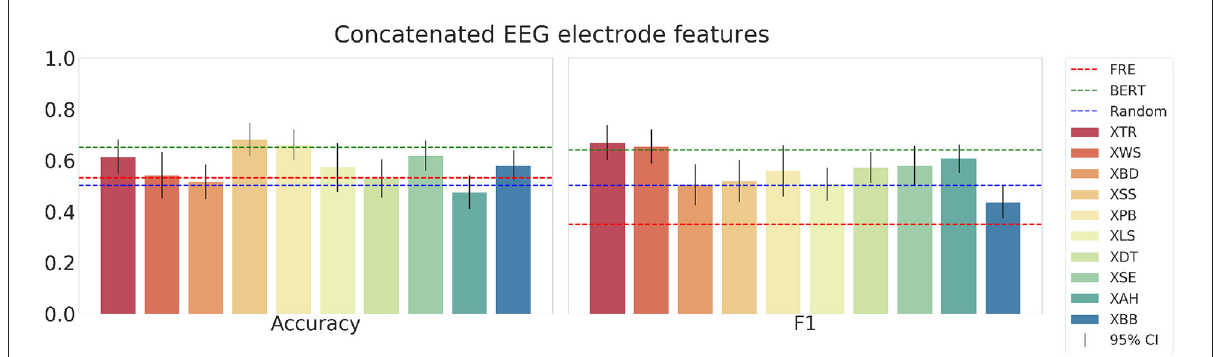
FIGURE12 The mean accuracy (left) mean, F1-score (right) with corresponding 95% confidence intervals and textual baselines are plotted for each subject in the held-out test dataset using the concatenated EEG electrode features after pre-processing with